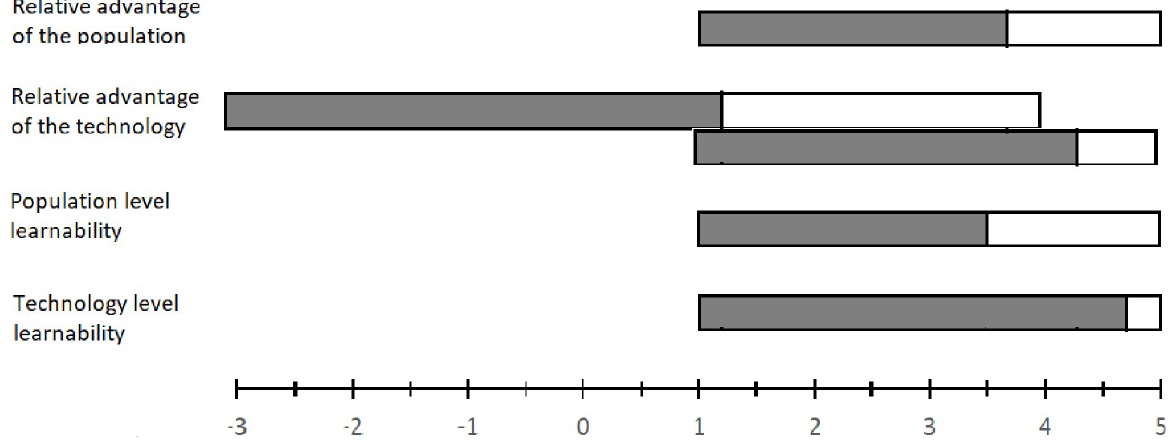
Fig 5. Farmers’ perception scores of the new groundnut plant spacing by four vectors of adoption factors. Legend: The right tips of the dark bars indicate the mean values of farmers’ perception scores of the vectors of the adoption factors.